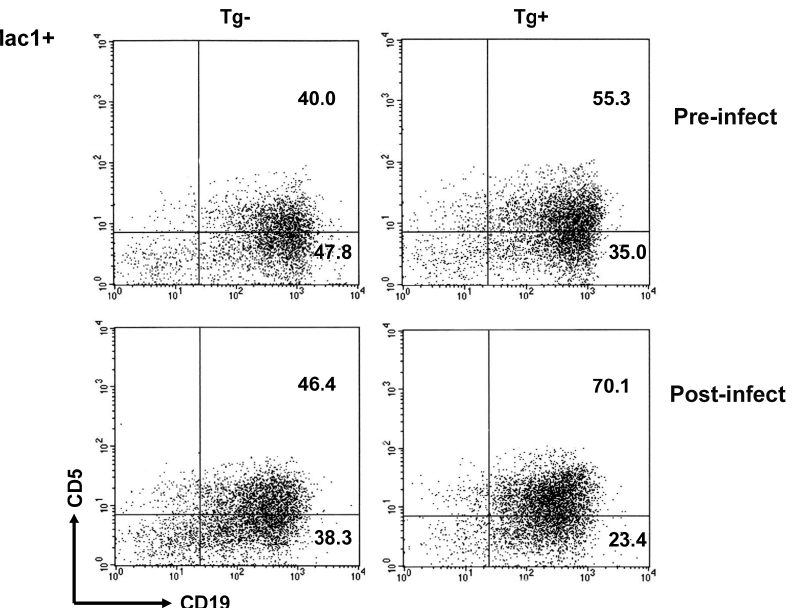
Figure 3. B cell analysis in PEC. Cells collected the PEC lavage before and after C.albicans inoculation were stained with antibodies and analyzed by FCM. Data are representative of four independent experiments.